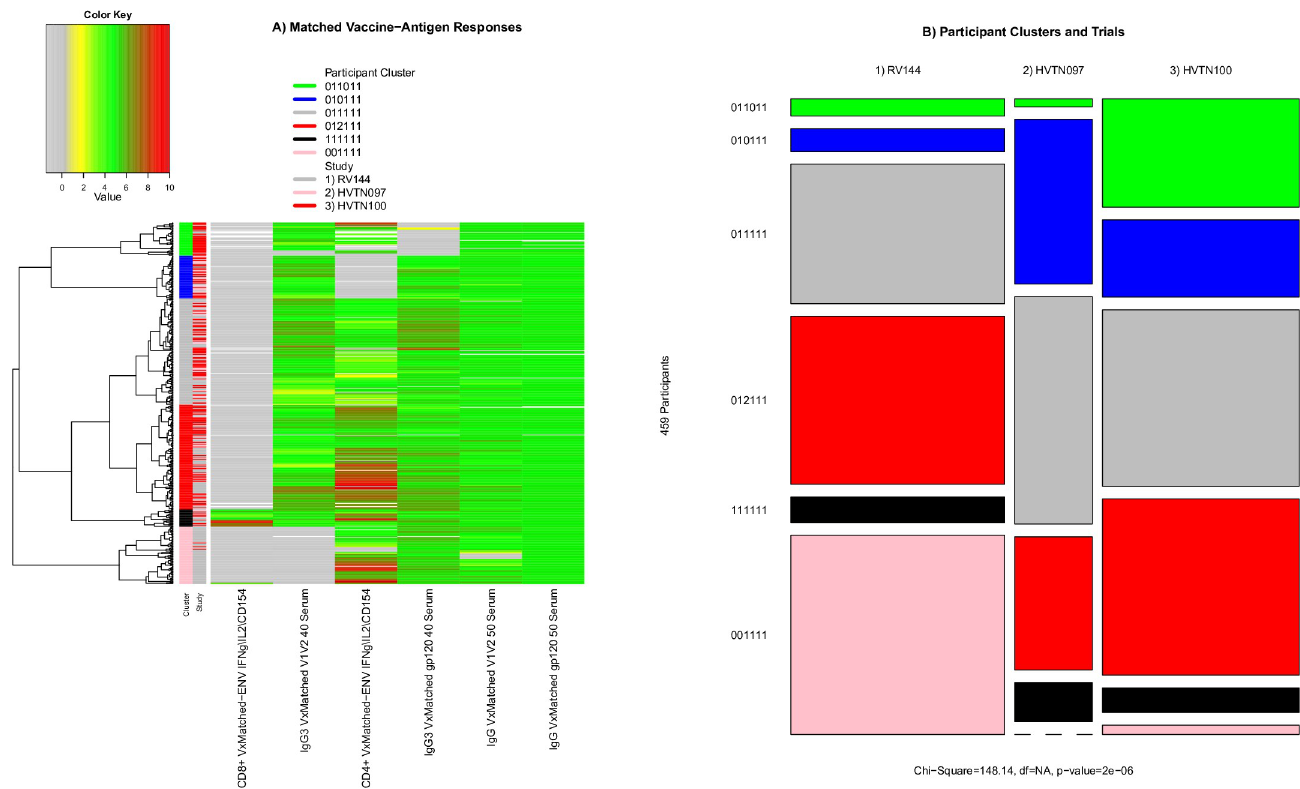
Fig 8. Immune response landscape of vaccine-matched responses and participant clustering based on vaccine-matched immune responses. A) Heatmap showing the vaccine-matched CD8+ T-cell polyfunctionality, anti-V1V2 IgG3 antibody binding, CD4+ T-cell polyfunctionality, anti-gp120 IgG3 antibody binding, anti-V1V2 IgG antibody binding, and anti-gp120 IgG antibody binding measurements used to organize participants into the six row clusters. B) The distribution of participants in each trial (column) in each cluster is represented by the row height. Box size is proportional to the number of participants.